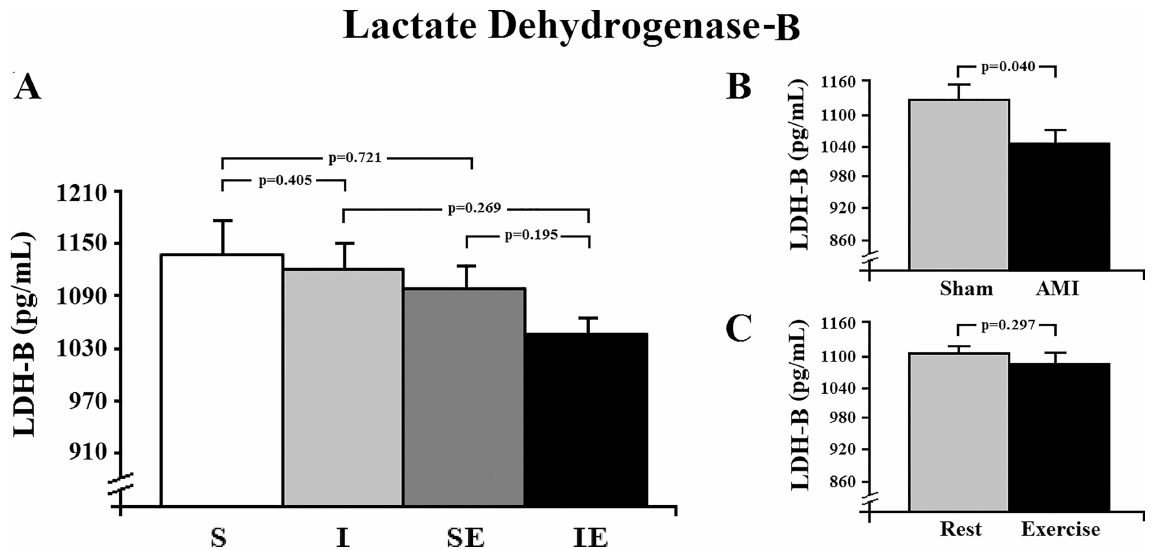
Figure 4 - Lactate Dehydrogenase-B protein levels in cardiac tissue. S: sham-operated rats without intense exercise session; SE: sham-operated rats + intense exercise session; I: acute myocardial infarction induced by left coronary artery ligation; IE: acute myocardial infarction induced by left coronary artery ligation + intense exercise session. AMI: left coronary artery ligation. Two way ANOVA was performed followed by Bonferroni’s post-hoc test. Panel A shows interaction between two factors (Sham/AMI and Rest/Exercise), p(interaction)=0.573. Panel B shows only factor Sham/AMI and Panel C shows only factor